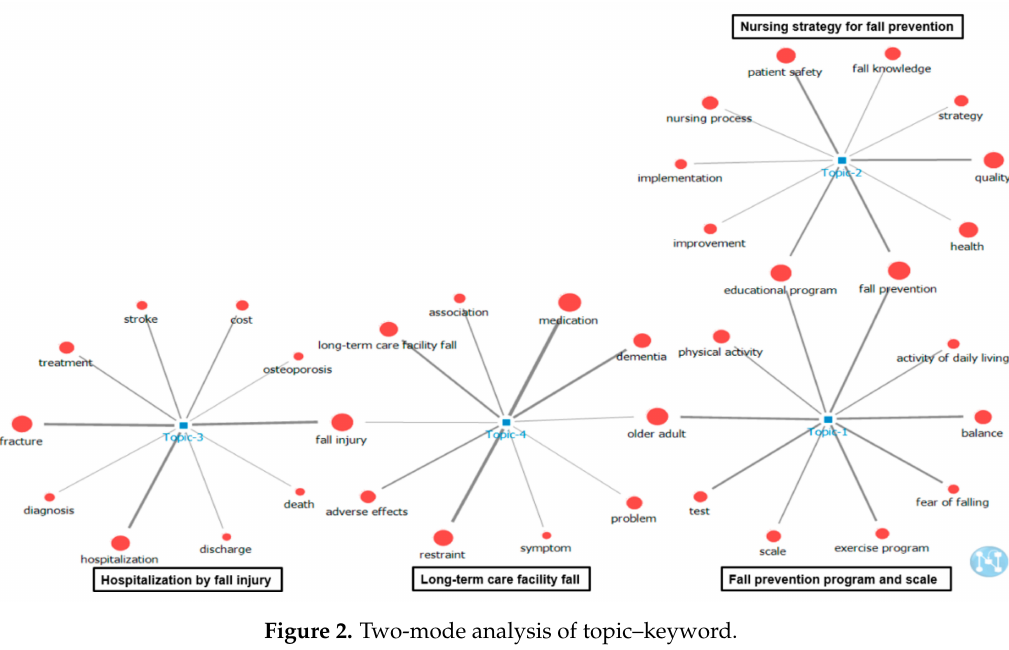
Figure 2. Two-mode analysis of topic–keyword.